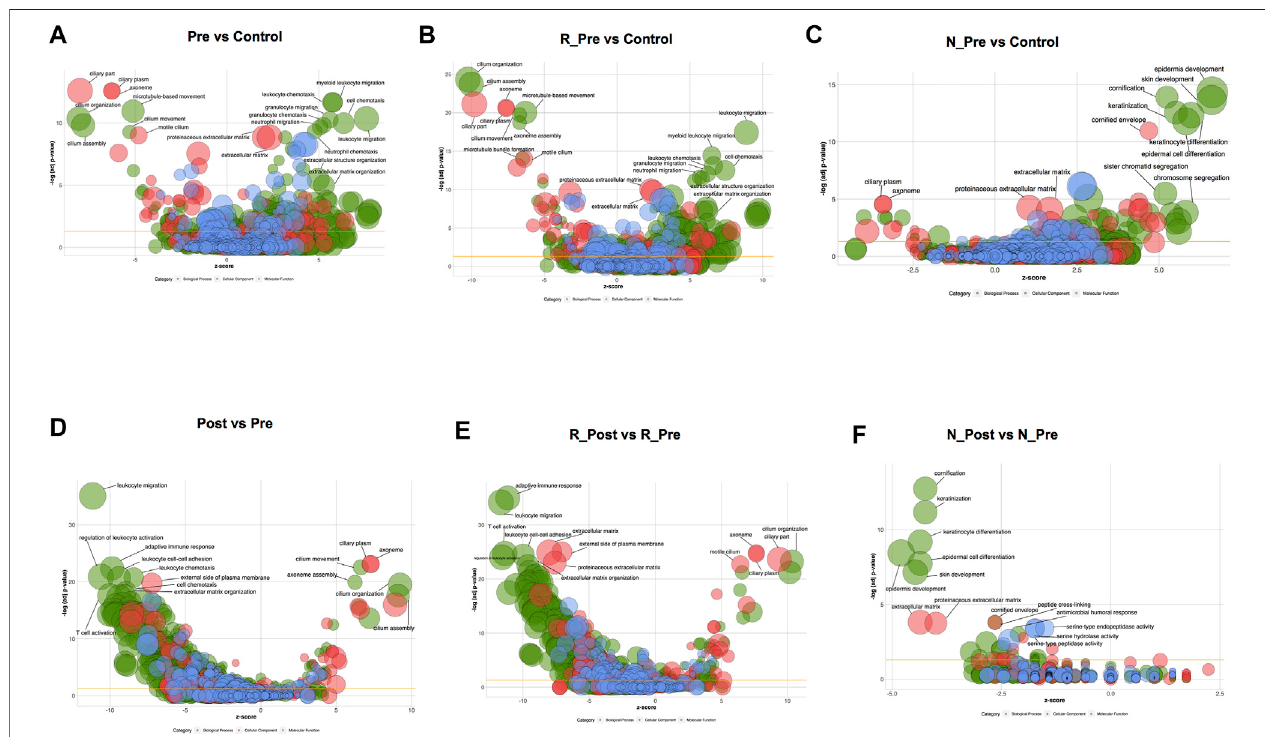
FIGURE 1 | Gene Ontology (GO) terms enriched in CRSwNP at baseline compared with the Control in all patients (A) , Responders (B) , and Non-responders (C) , see Supplementary Tables S2 – S4 for more details. GO terms enriched in nasal polyps after oral glucocorticoids treatment compared to baseline in all patients (D) , Responders (E) , and Non-responders (F) , see Supplementary Tables S8 – S10 for more details. The area of bubble presents the number of genes in each term (BiologicalProcesstermsingreen;CellularComponenttermsinred;MolecularFunctiontermsinblue)with-Logadjusted p -valuethe Y -axis,withz-scorethe X -axis (upregulated, z-score > 0; downregulated, z-score < 0). Abbreviation: Pre, all CRSwNP_Pre-treatment; Post, all CRSwNP_Post-treatment; R_Pre, Responder_Pre- treatment; N_Pre, Non-responder_Pre-treatment; R_Post, Responder_Post-treatment; N_Post,